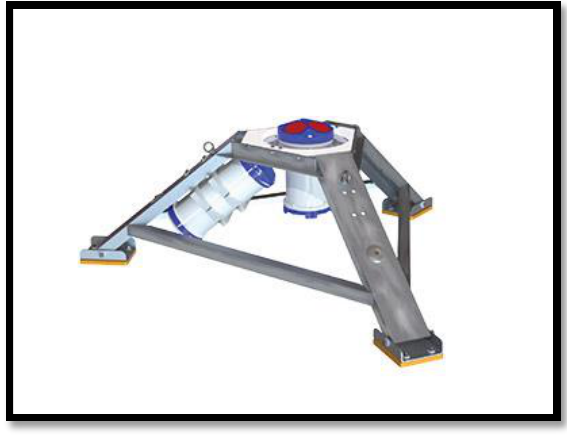
Figure 1. An example of an ADCP device (news,